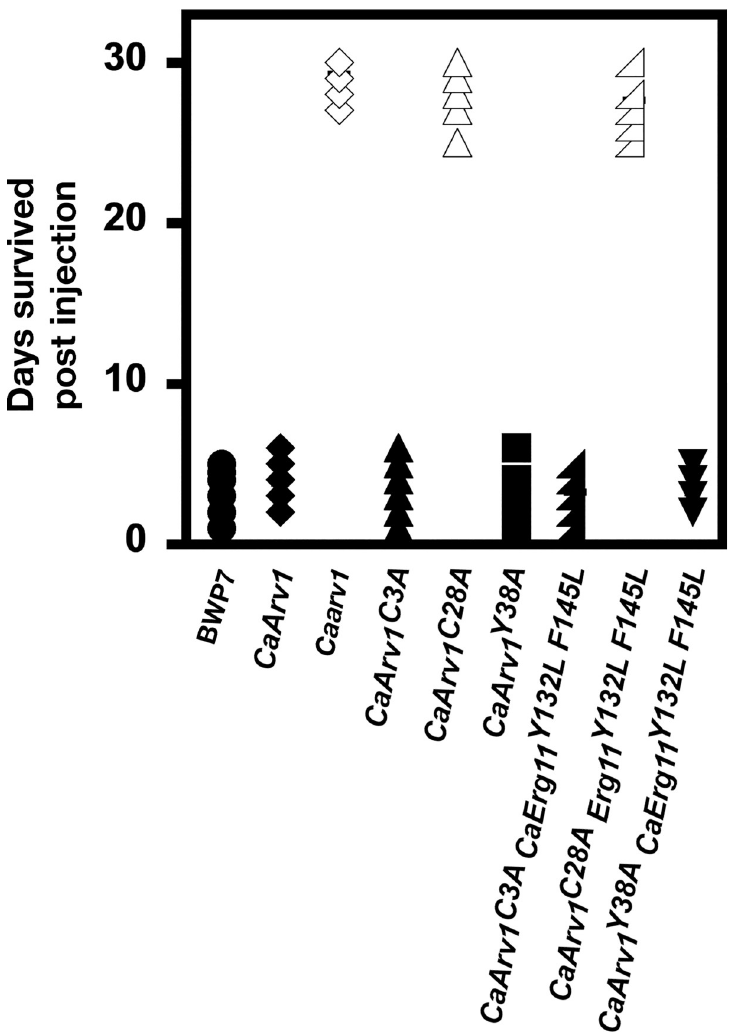
Caarv1/Caarv1 cells expressing CaArv1 C3A , CaArv1 C28A , CaArv1 Y38A , or Caarv1/Caarv1 cells co-expressing CaArv1 C3A and Erg11 Y132L F145L , CaArv1 C28A and Erg11 Y132L F145L , or CaArv1 Y38A and Erg11 Y132L F145L . Viability